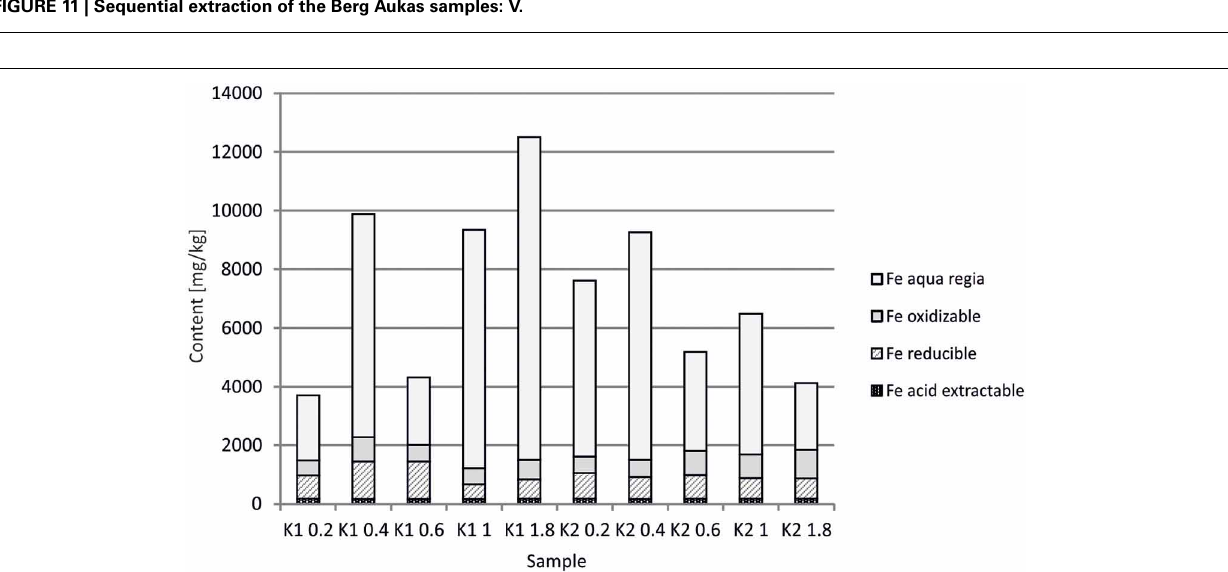
FIGURE 12 | Sequential extraction of samples from Kombat: